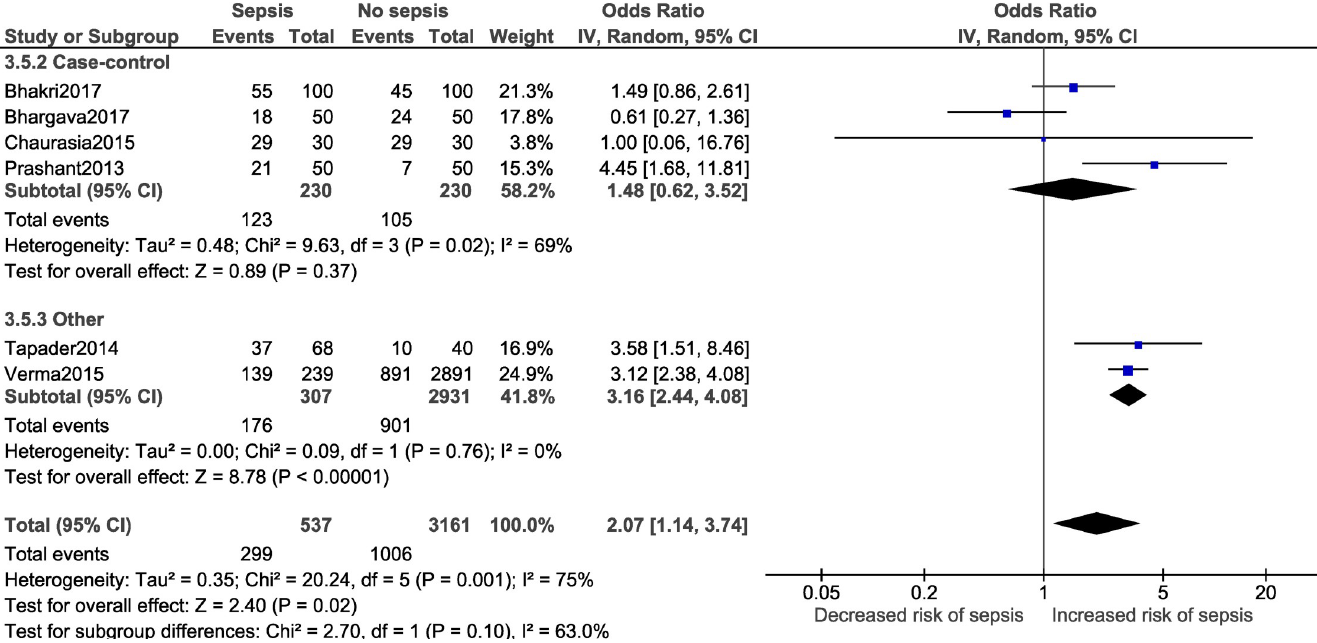
Fig 14. Forest plot showing random-effects meta-analysis of neonates, with and without sepsis, born to mothers delivering < 37 weeks of gestation, sub-grouped by study design (6 studies) [IV: Inverse Variance; CI: Confidence Interval].